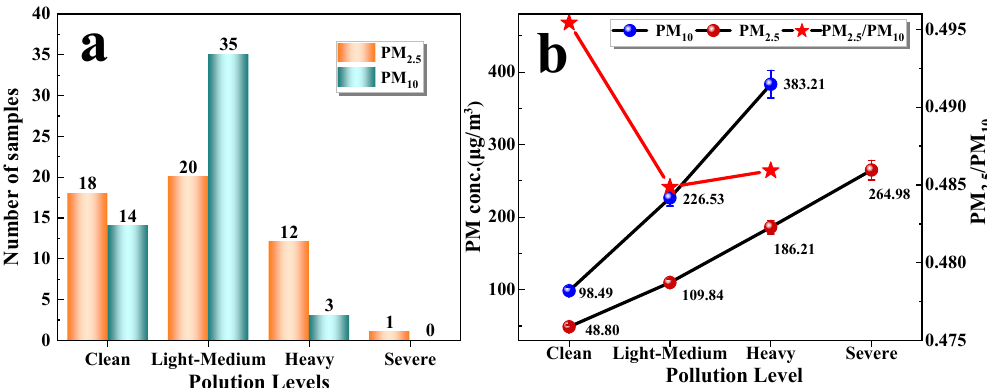
Figure 3. The number of samples that PM 2.5 and PM 10 were at different pollution levels ( a ); the concentrations of PM 2.5 and PM 10 at different pollution levels ( b ).